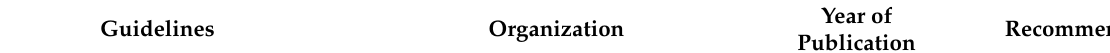
Table 3. Guidelines on the assessment of older adults with